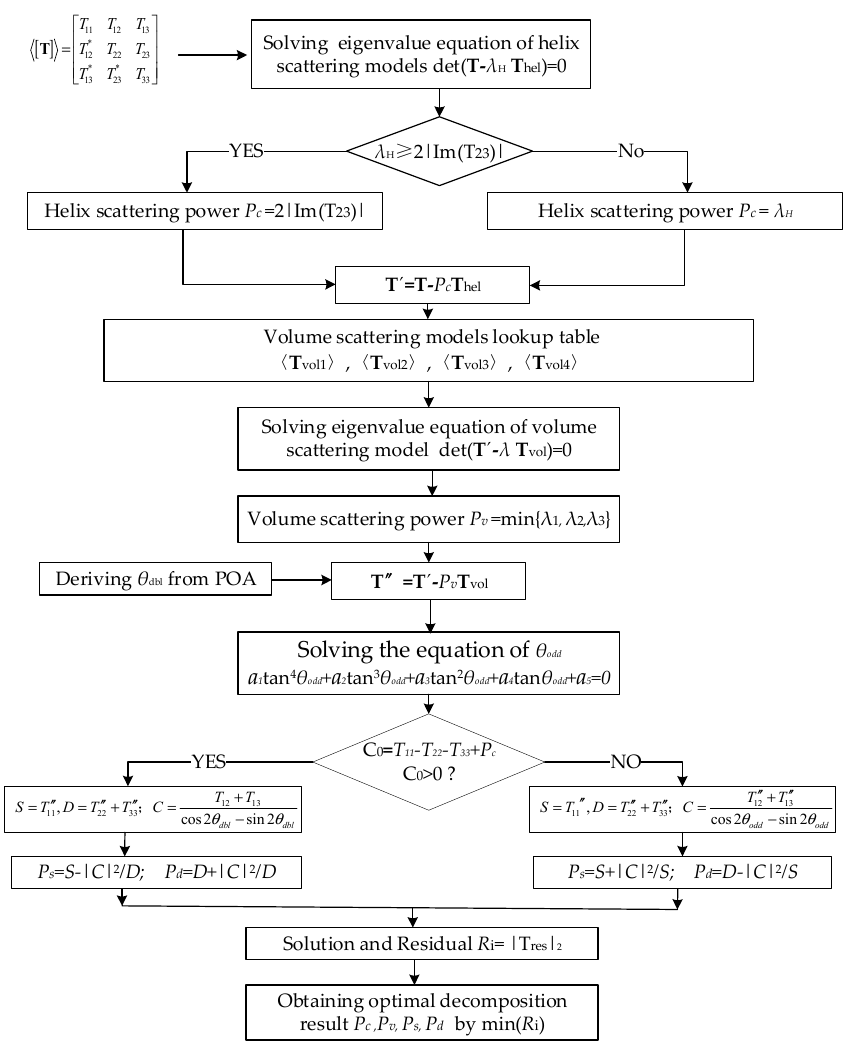
Figure 3. Flowchart of the proposed decomposition.